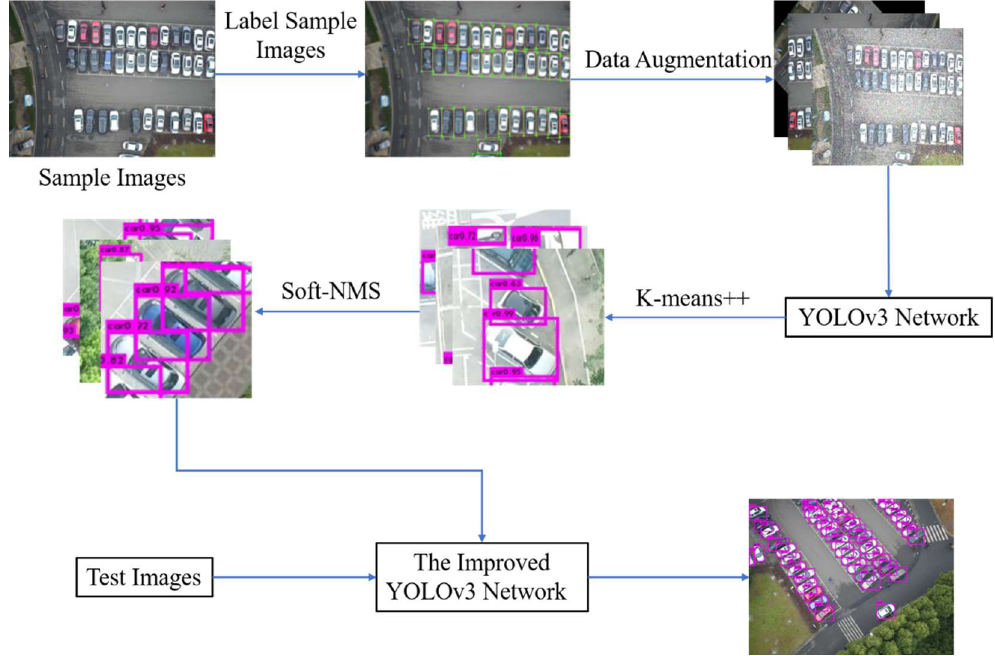
Figure 1. The vehicle detection framework based on the improved YOLOv3 network. The detected target is in the purple box.